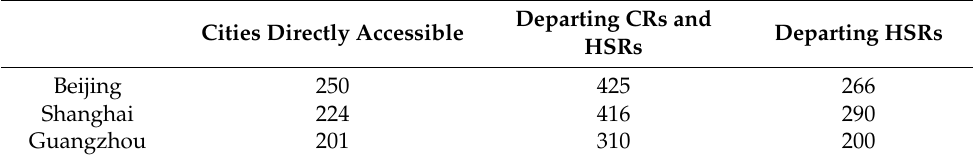
Table 3. Trains in service in the three megacities. Cities Directly Accessible